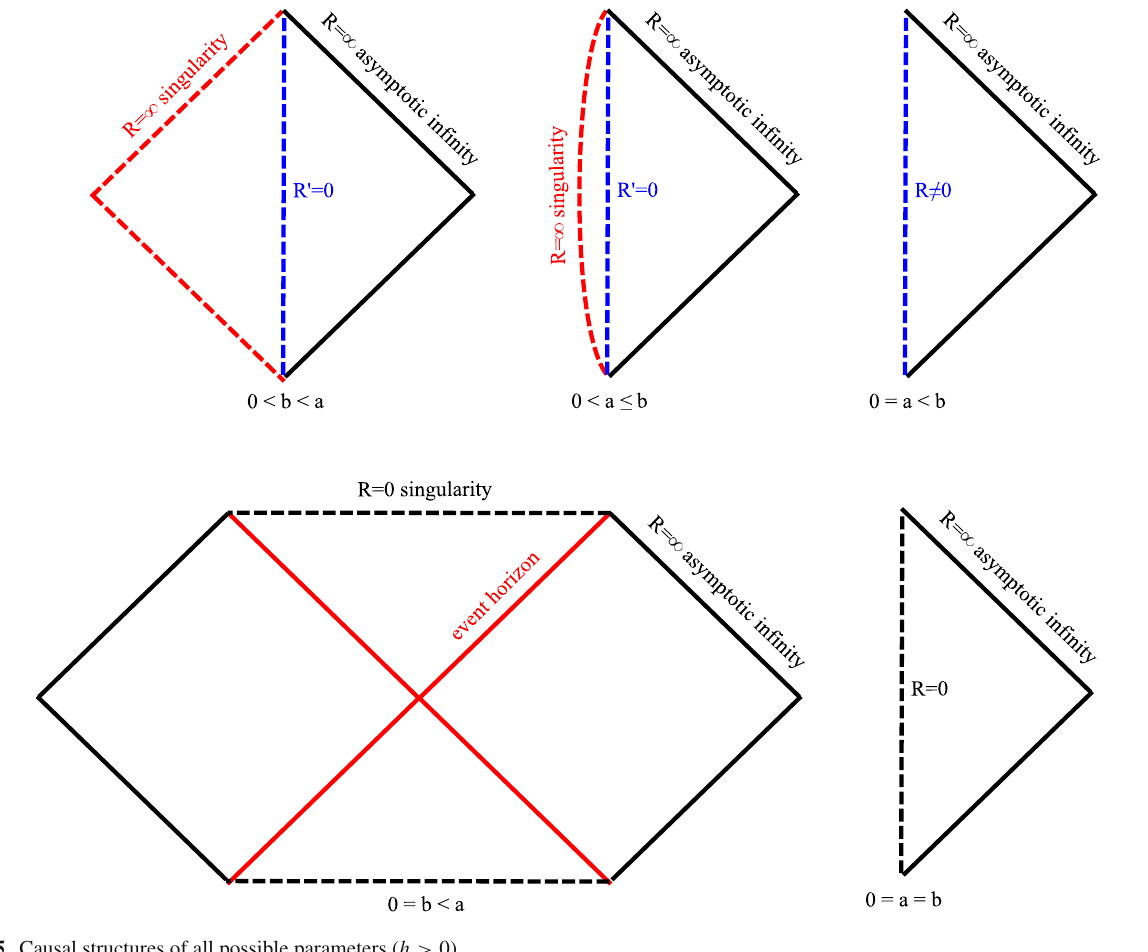
Fig. 5 Causal structures of all possible parameters ( h >